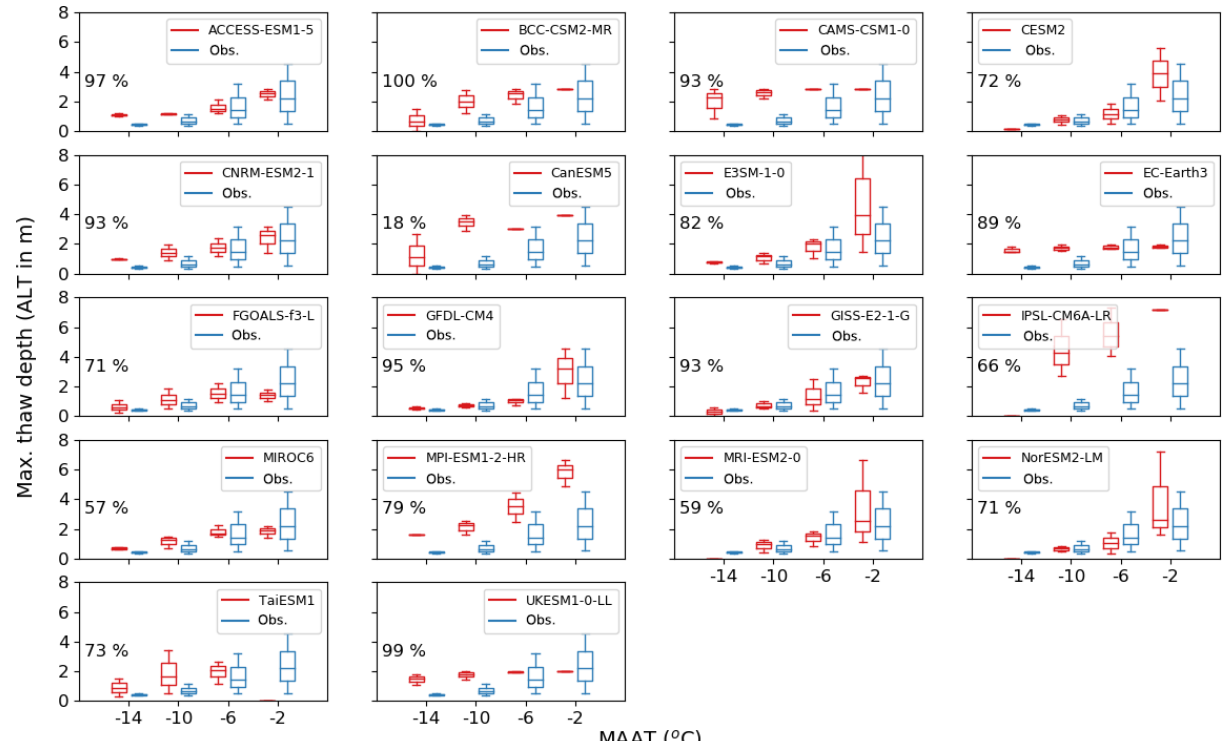
Figure 9. Active layer thickness (ALT) as a function of local MAAT for the CMIP6 models (in red) and the climatological period 1995–2014. Observations of the active layer (in blue) are from the CALM sites, and the air temperatures are from the large-scale WFDEI data set. The percentage of the observed sites which also have permafrost in the models is shown in each subplot. Table 4. CMIP6 model evaluation metrics summary compared with observations and CMIP5. Individual CMIP6 models are in Tables S1.2 and S2.3. CMIP6 CMIP5 Observed (range) Ensemble mean Percent within Ensemble mean Percent within (25th–75th percentile) obs. range (25th–75th percentile) obs.